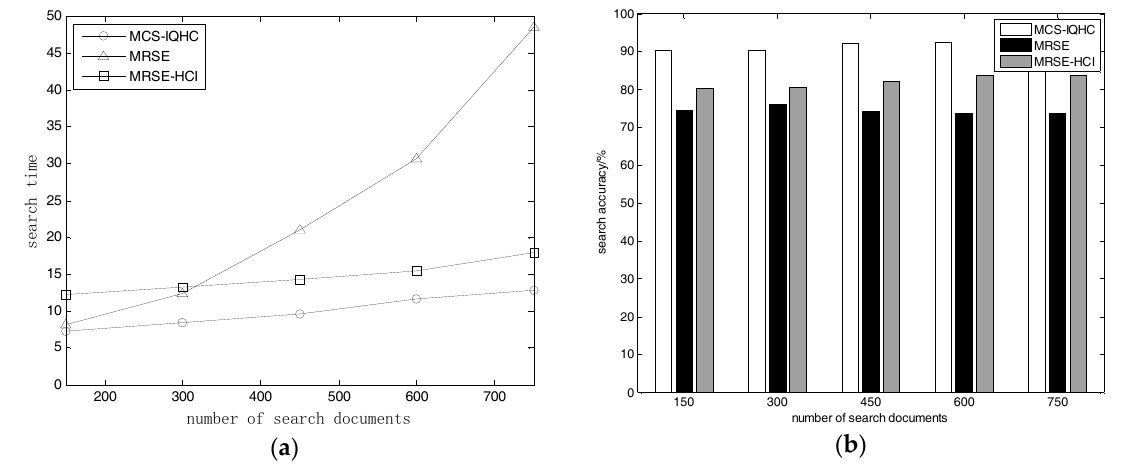
Figure 2. ( a ) Relationship between document quantity and search time of various data sets; ( b ) Relationship between document quantity and search accuracy of various data sets.